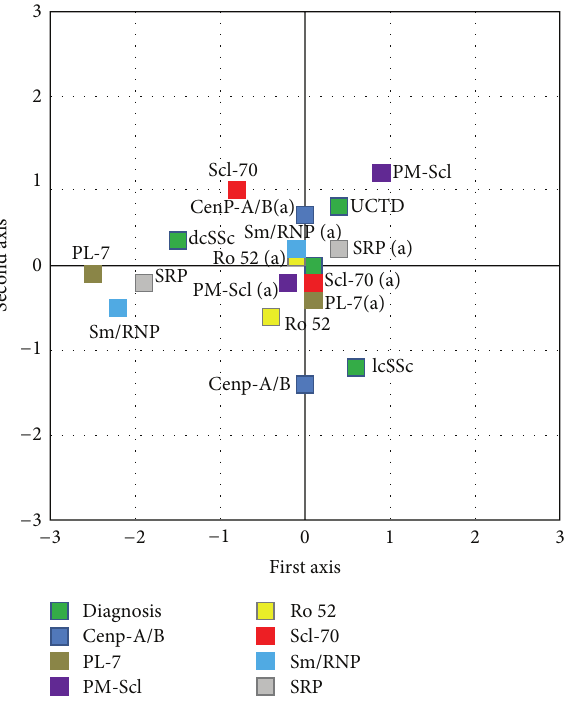
Figure 1: Multiple correspondence analysis showing the association between clinical and serological variables.